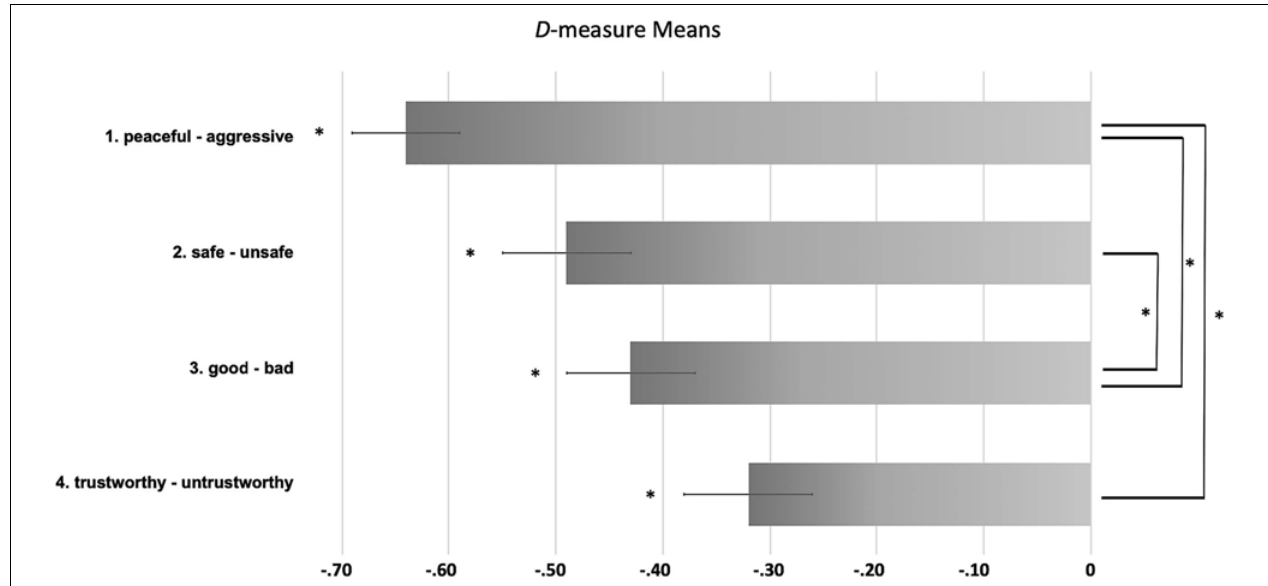
FIGURE 1 | Comparison of mean D -measures of the four attribute dimensions. Means are displayed with ± 1 standard error of the mean (SEM). Negative D -measure scores indicate a faster response ratio to the negative dimension concept and PaCA and the positive dimension concept and Non-PaCA, respectively. D -measures significantly differing from zero (Tukey-Test) are marked with ∗ , indicating p <